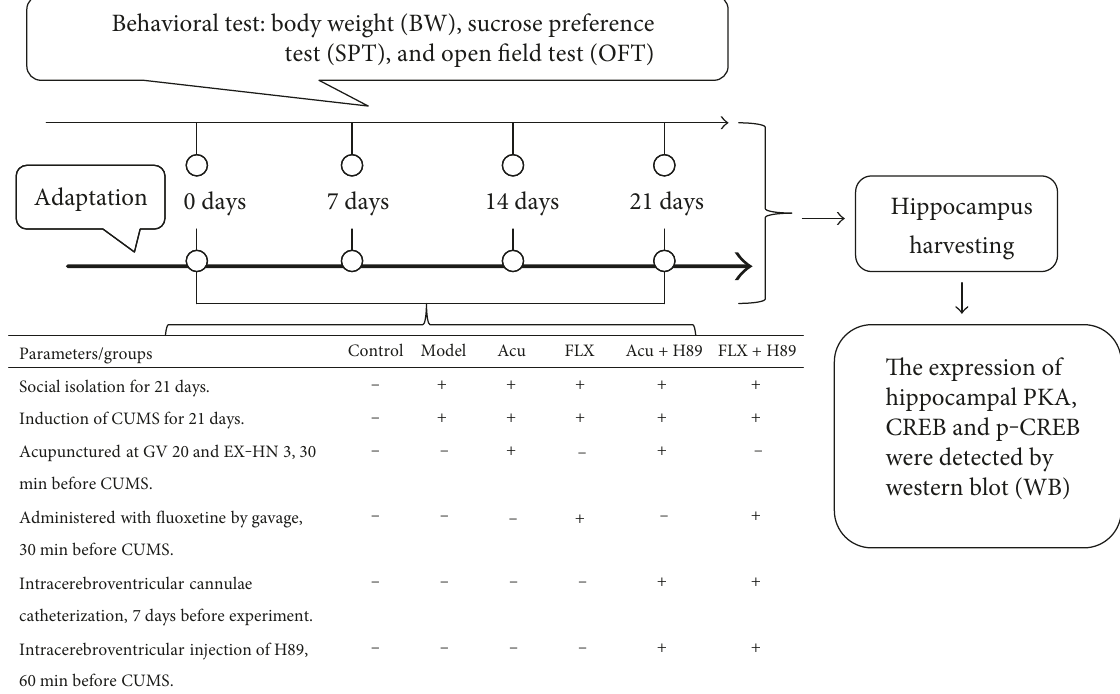
Figure 1: Experimental procedures. Acu: acupuncture group; FLX: fl uoxetine group; Acu+H89: Acupuncture +H89 group; FLX +H89: Fluoxetine+ H89 group; PKA- α : protein kinase A- α ; CREB: cyclic adenosine monophosphate response element-binding protein; p-CREB: Phosphor-CREB.